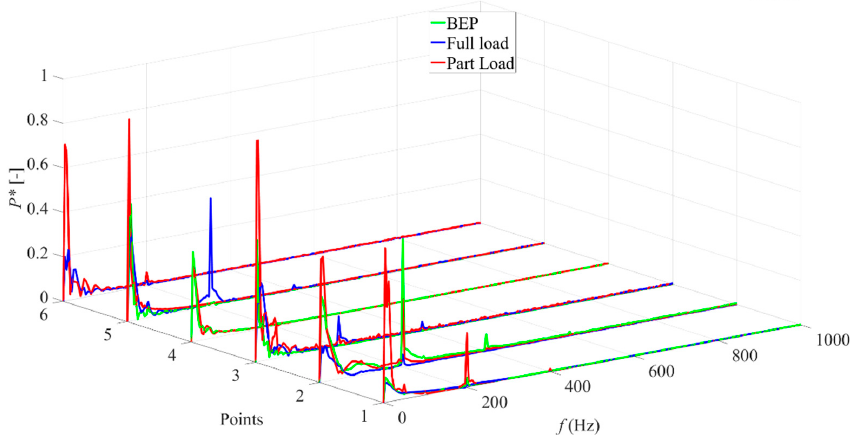
Figure 17. Frequency spectrum of pressure time signals along runner blade.